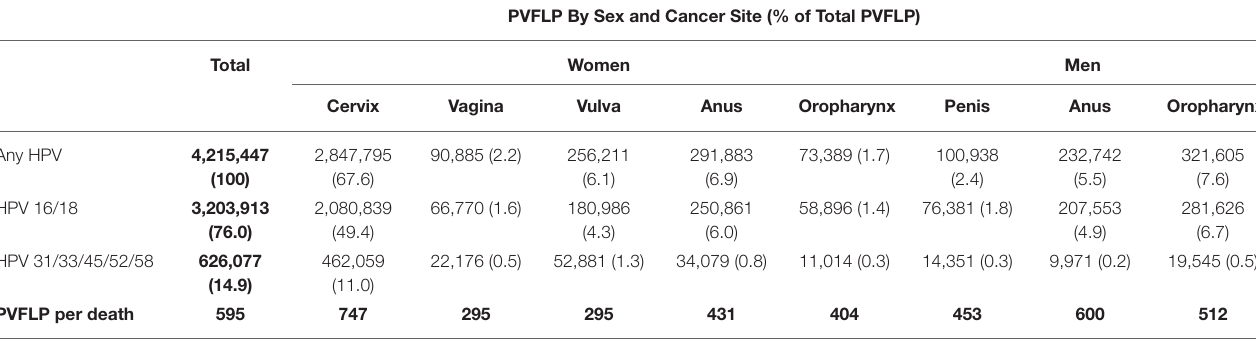
TABLE 4 | Estimated present value of future lifetime productivity due to HPV-attributable cancer deaths by sex and HPV type (in thousands, 2017